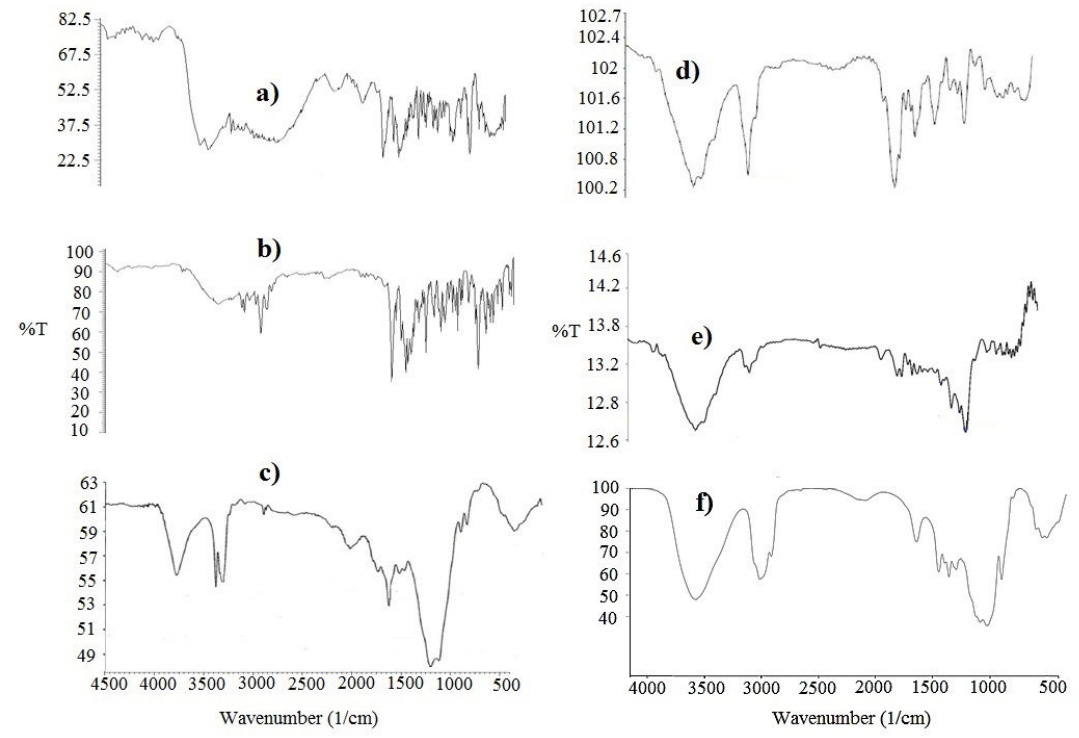
FIGURE 5.1 - FTIR spectra of a) OND HCl, b) OND c) EC d) PVP K-30 e) HPβCD f)